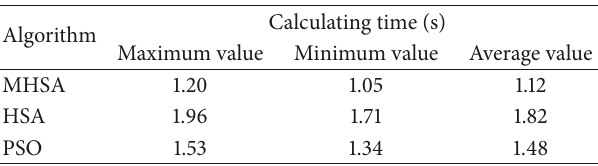
Table 3: Comparison of the computation time of the MHSA, HSA, and PSO in Case 1.